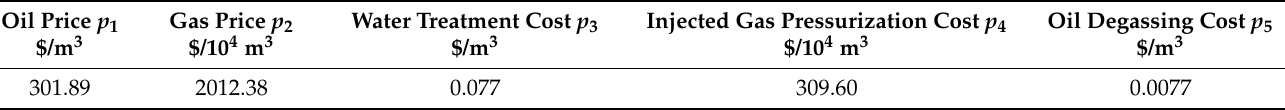
Table 2. Gas-lift economical parameters.